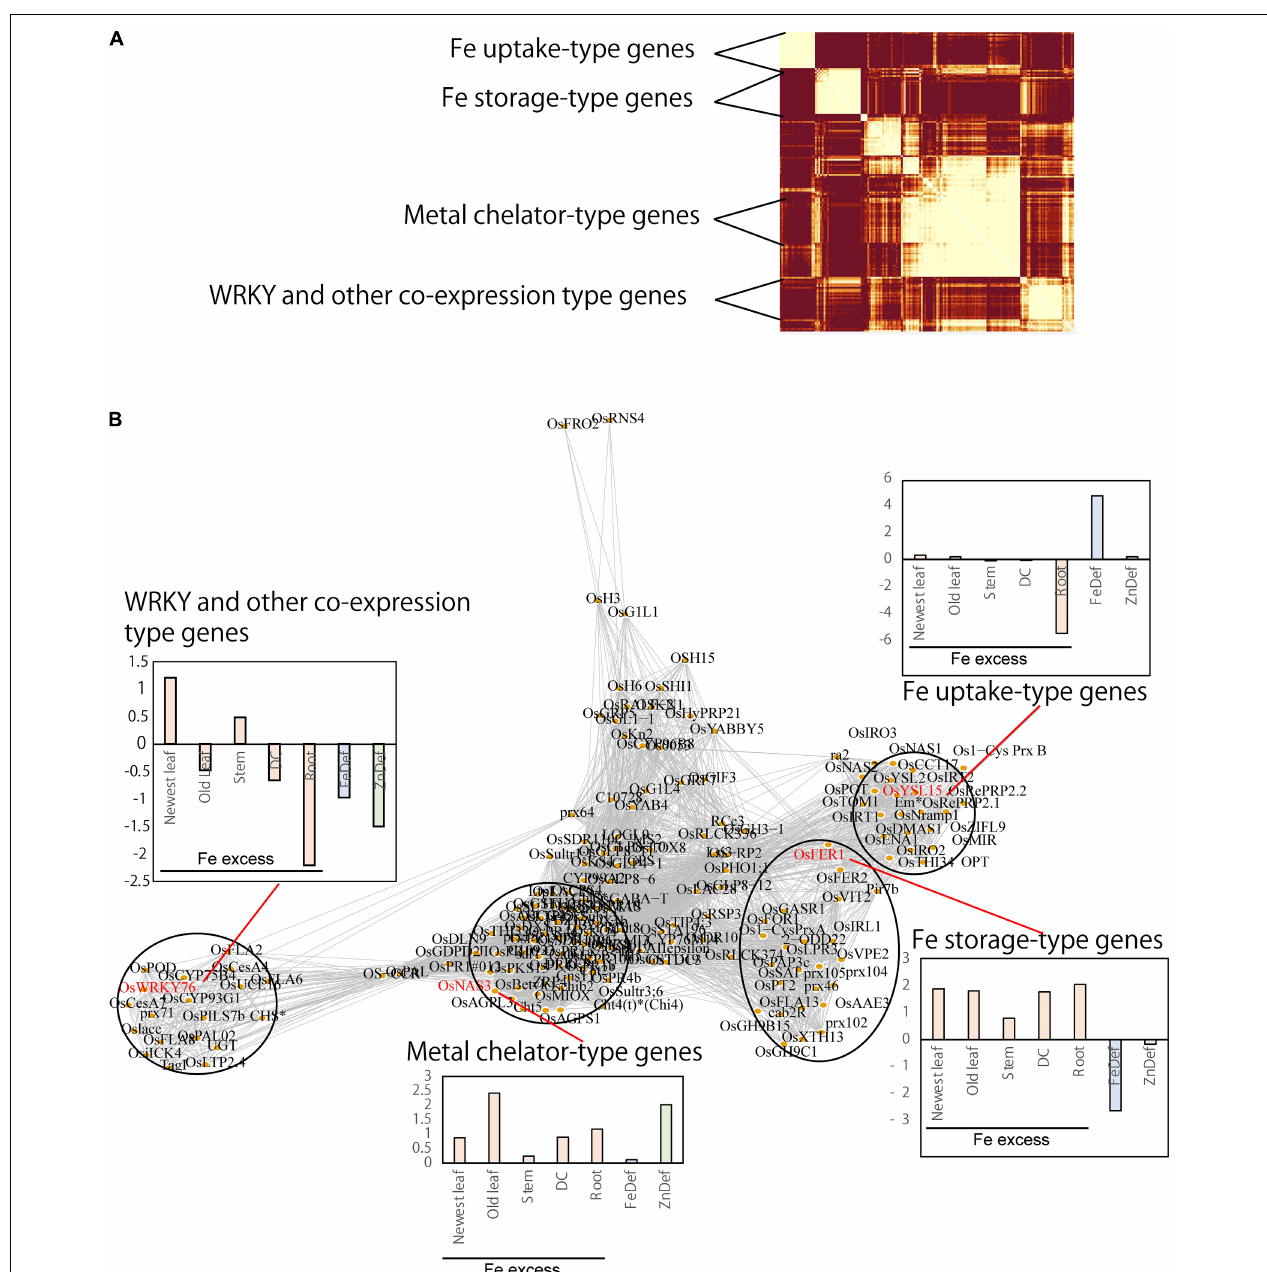
FIGURE 2 | Network analyses of gene expression patterns related to the transcriptional response to Fe excess in each rice tissue type (root, DC, stem, old leaf and newest leaf) analyzed and visualized using the R package WGCNA (weighted correlation network analyses, version 1.68). Differentially expressed genes in four Fe excess treatments ( × 10 Fe, × 20 Fe, × 50 Fe, × 70 Fe) were used for this analysis. In addition to the transcriptional response to Fe excess in each tissue, the responses to Fe deficiency and Zn deficiency in rice were also concurrently analyzed. To visualize the clustered genes, only genes with names (under the RAP-DB Gene Symbol system) were used. In this network, similar expression patterns were clustered (A) , connected to each other and placed together (B) . Expression was largely clustered into four categories. As representative genes for each category, the transcriptional responses (times induced under each stress) of OsWRKY76 (WRKY and other co-expression), OsNAS3 (metal chelator), Ferritin 1 (Fe storage) and OsYSL15 (Fe uptake) are shown as log2-ratio bar graphs. In each cluster, the gene with a clear role and function in Fe homeostasis are selected as a representative example and shown in red